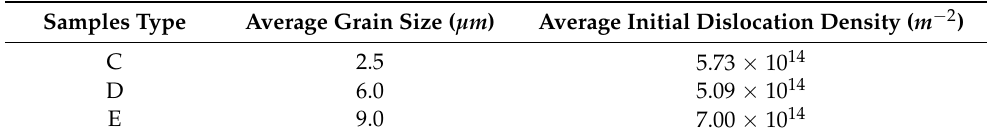
Table 2. Microstructural features, model input parameters for DMLS Ti6Al4V (ELI) alloy